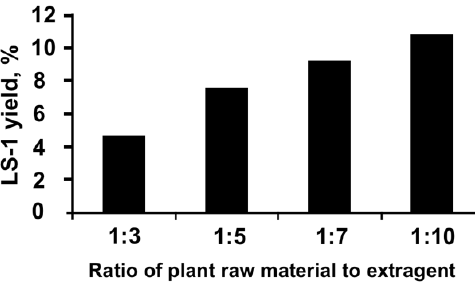
Figure 1. Elaborating optimal technology for LS-1: choosing the correct ratio of raw material to ex- tragent.